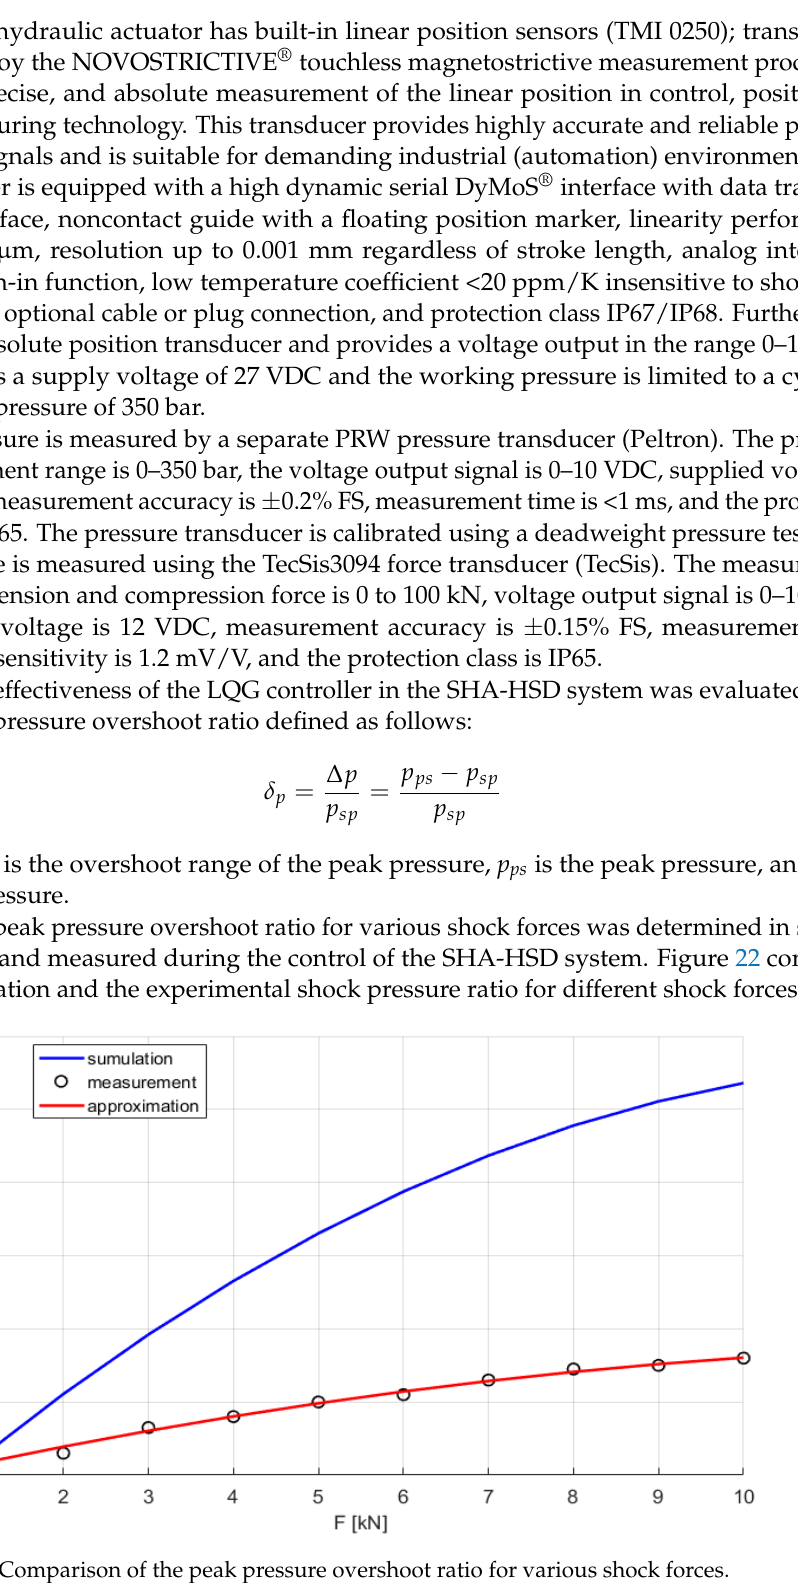
Figure 22. Comparison of the peak pressure overshoot ratio for various shock forces. The experimental results show that the LQG controller in fact damps the shock pres- sure more effectively than the results from the simulation